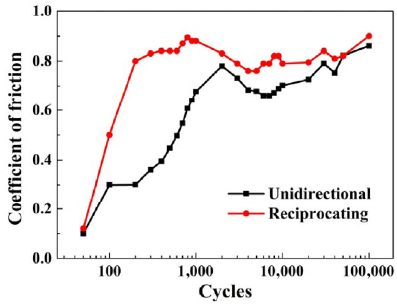
Fig. 12 Evolution of the friction coefficient with the number of cycles.